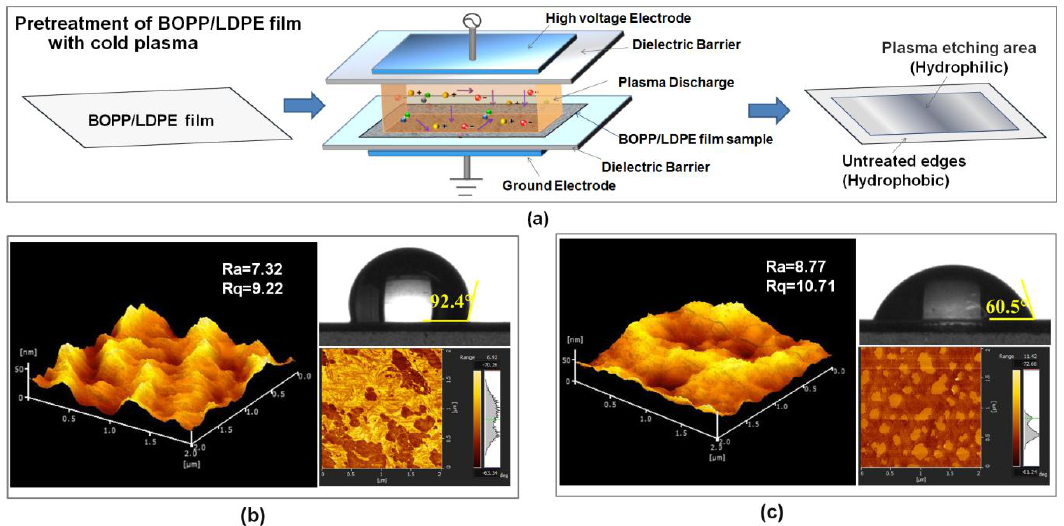
Figure 1. ( a ) Illustration of cold plasma treatment of biaxially oriented polypropylene (BOPP) low density polyethylene (LDPE) films; atomic force microscopy (AFM) surface images and static water contact angle (SWCA) photos of BOPP/LDPE films ( b ) before and ( c ) after cold plasma treatment.